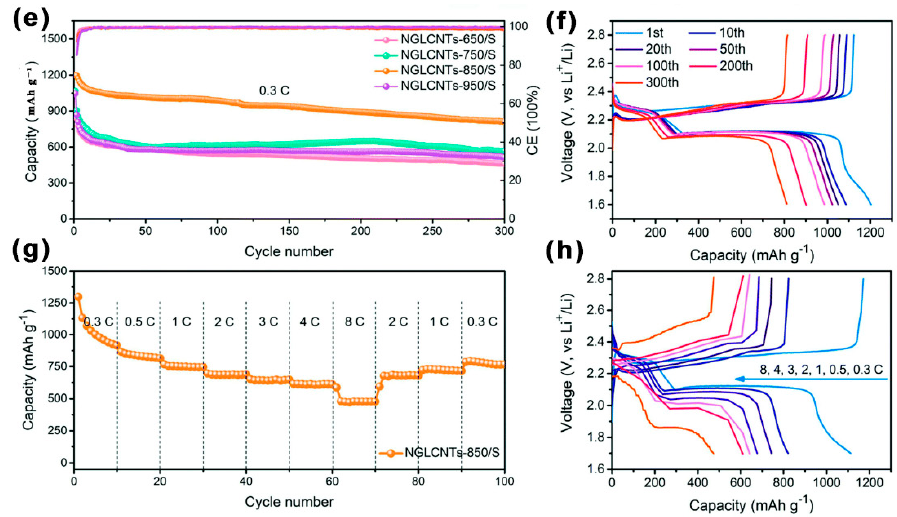
Figure 11. ( a ) Synthesis scheme of the hierarchical porous carbons (HPC) [96]. ( b ) SEM image of rNGO/S (the inset was a schematic) [97]. ( c ) UV–Vis absorption spectra (the inset was an optical photograph) of Li 2 S 6 solution before and after adding BCPs. ( d ) CV curves of BCP/S-6 at 0.1 mV s − 1 . Electrochemical performances of NGLCNTs-850/S cathode [94]. ( e ) Cycling capacity and coulombic e ffi ciency of NGLCNTs-850/S at 0.3 C. ( f ) Galvanostatic discharge and charge curves at 1–300 cycles. ( g ) Rate performance from 0.3 C to 8 C. ( h ) Galvanostatic discharge–charge curves at di ff erent C- rates [98].